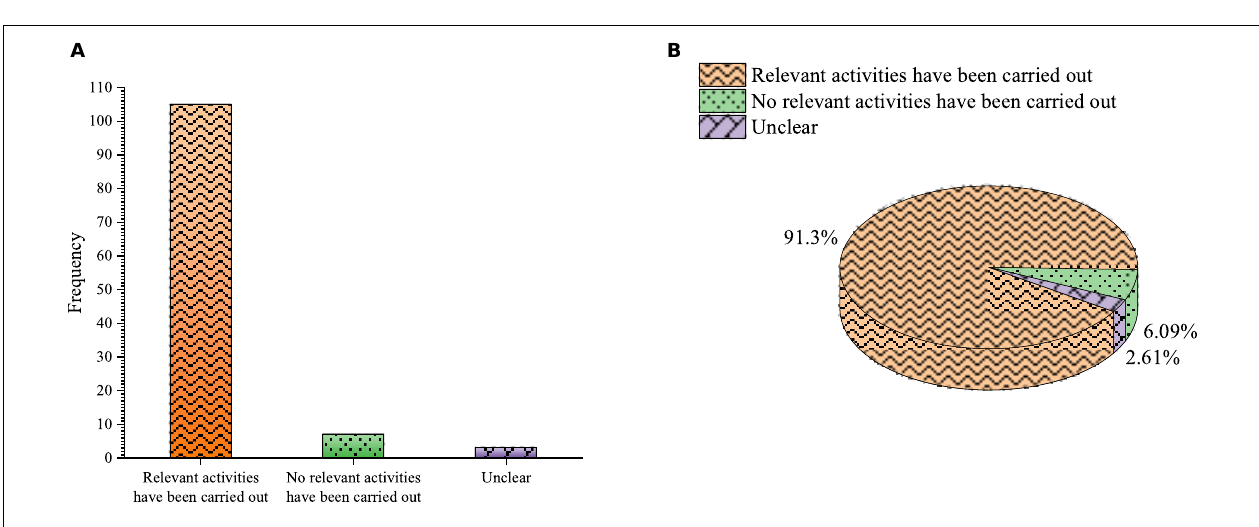
FIGURE 7 | Whether the university has carried out entrepreneurship education-related activities (A) frequency (B)